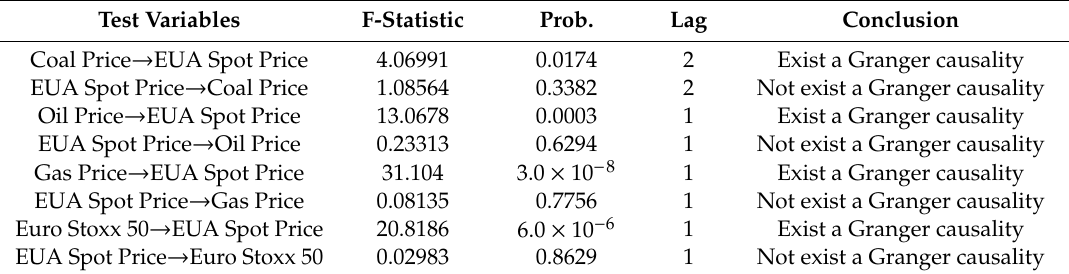
Table 3. Granger causality test results for EUA spot price and its external